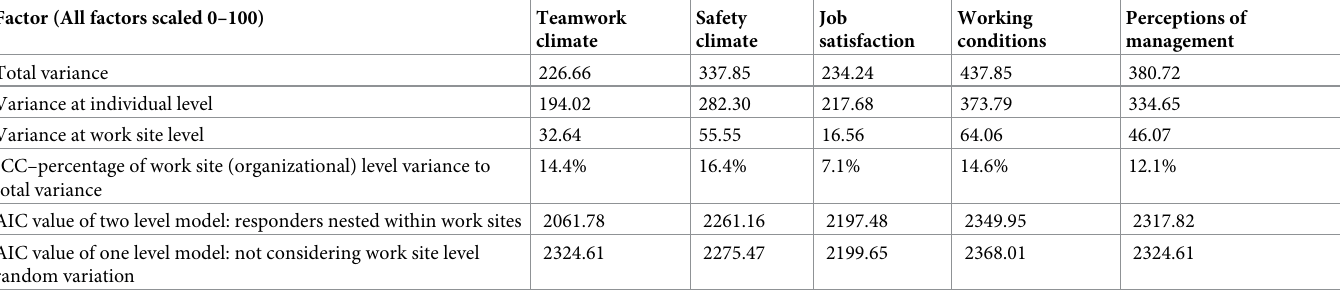
Table 1. Total variance of patient safety climate factor scores. The scores are partitioned at individual and work site (organisational) levels. The ICC coefficients show percentage of organisational to total variance. The AIC value indicates model fit. Factor (All factors scaled